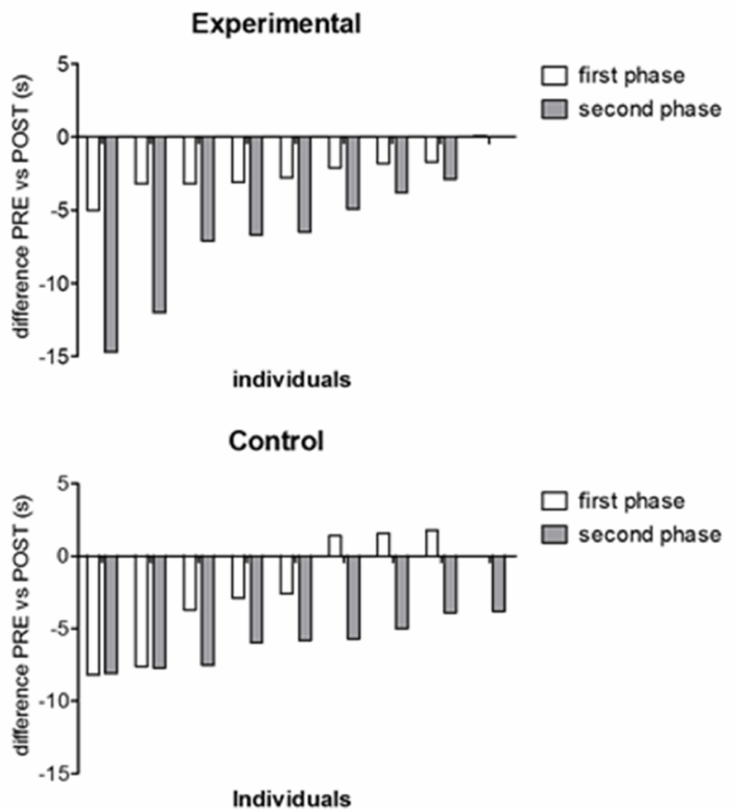
Figure 3. Individual changes from baseline in walking execution time. Individual changes from baseline the 25FW test are reported separated in the two phases for experimental (upper panel) and control (lower panel) treatment. The values are sorted from the greater to the lower individual change. There was an overall trend to greater changes in the second phase (from T2 to T3) than in the first (from T0 to T1) for both experimental ( p = 0.01) and control treatment ( p =